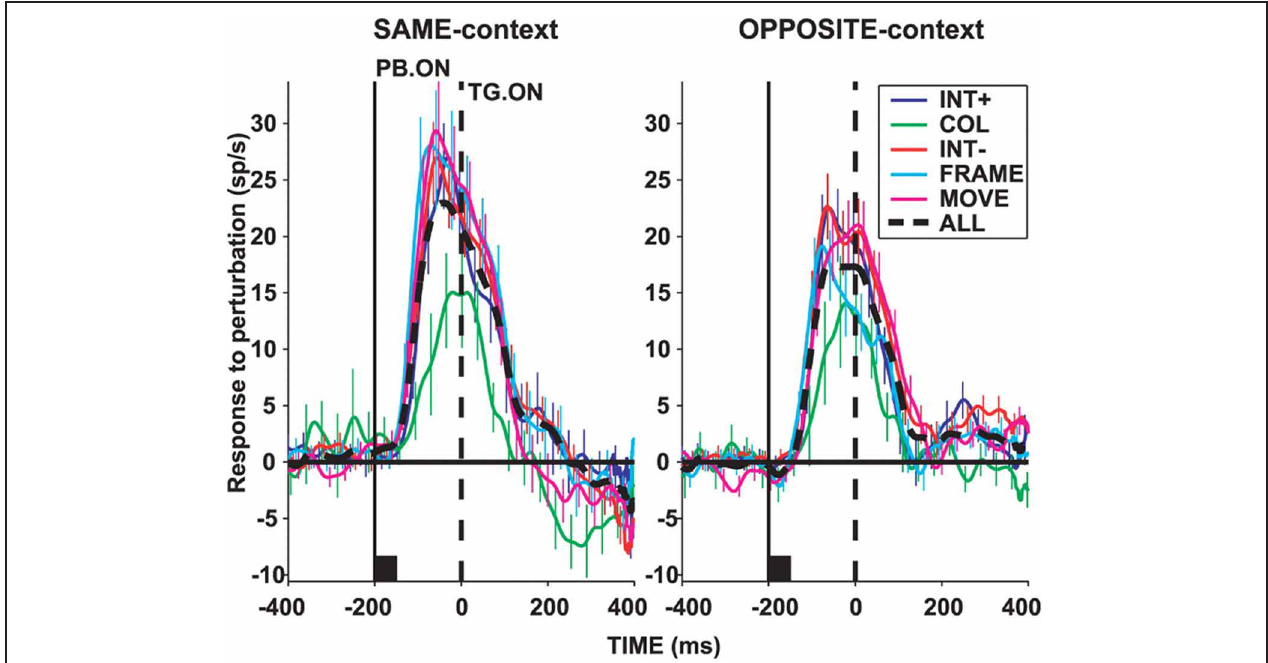
(“SAME-context”), or outside (“OPPOSITE-context”) the receptive field. Visual perturbations included an increase (“INT + ”), or decrease (“INT − “) in stimulus intensity, a change in color (“COL”), a shift in stimulus position (“MOVE”), or appearance of a bounding frame (“FRAME”). In each case, the visual perturbation was task-irrelevant and had no bearing on response selection. Reprinted with permission (Balan and Gottlieb,